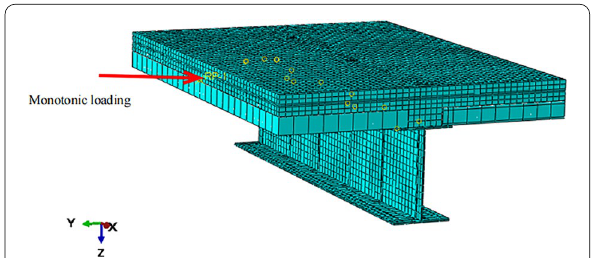
Fig. 13 Transverse push-out test model